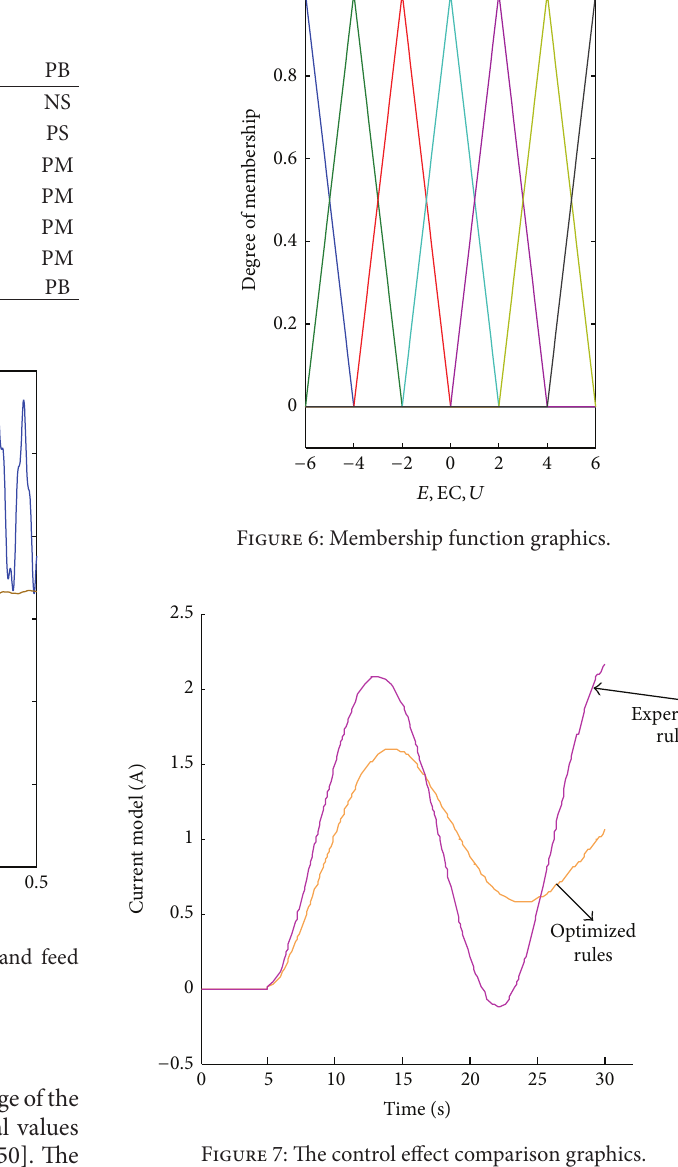
Figure 7: The control effect comparison